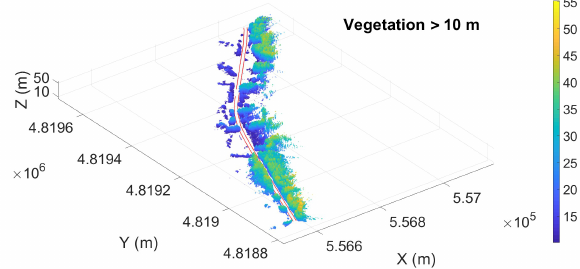
Figure 9. Vegetation points with greater height than 10